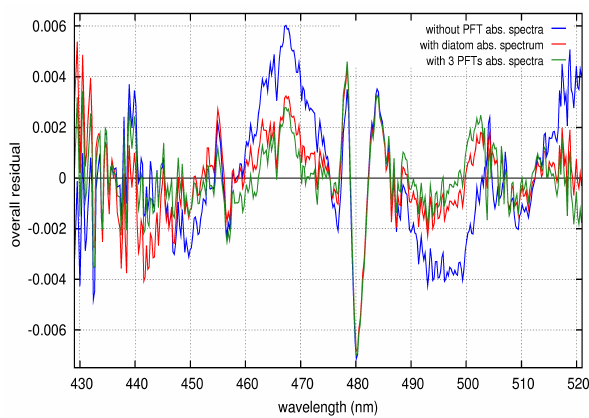
Fig. 3. Fourth-derivative curves of the specific absorption spectra of Fig. 3. Fourth derivative curves of the specific absorption spectra the three PFTs shown in Fig. 1: diatoms (blue), coccolithophores of the three PFTs shown in Fig. 1: diatoms (blue), coccolithophores (green) and dinoflagellates (red). The latter curve was scaled to (green) and dinoflagellates (red). The latter curve was scaled to 0.75. 0.75.